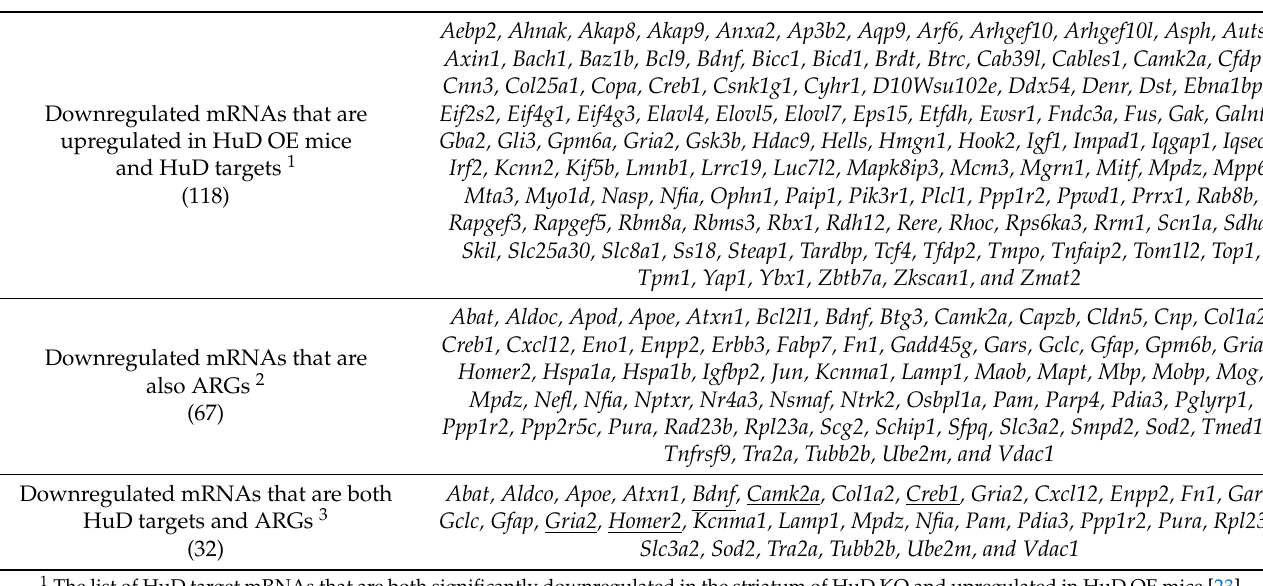
Table 1. List of genes with downregulated mRNAs in HuD KO striatum that are HuD targets and ARGs.